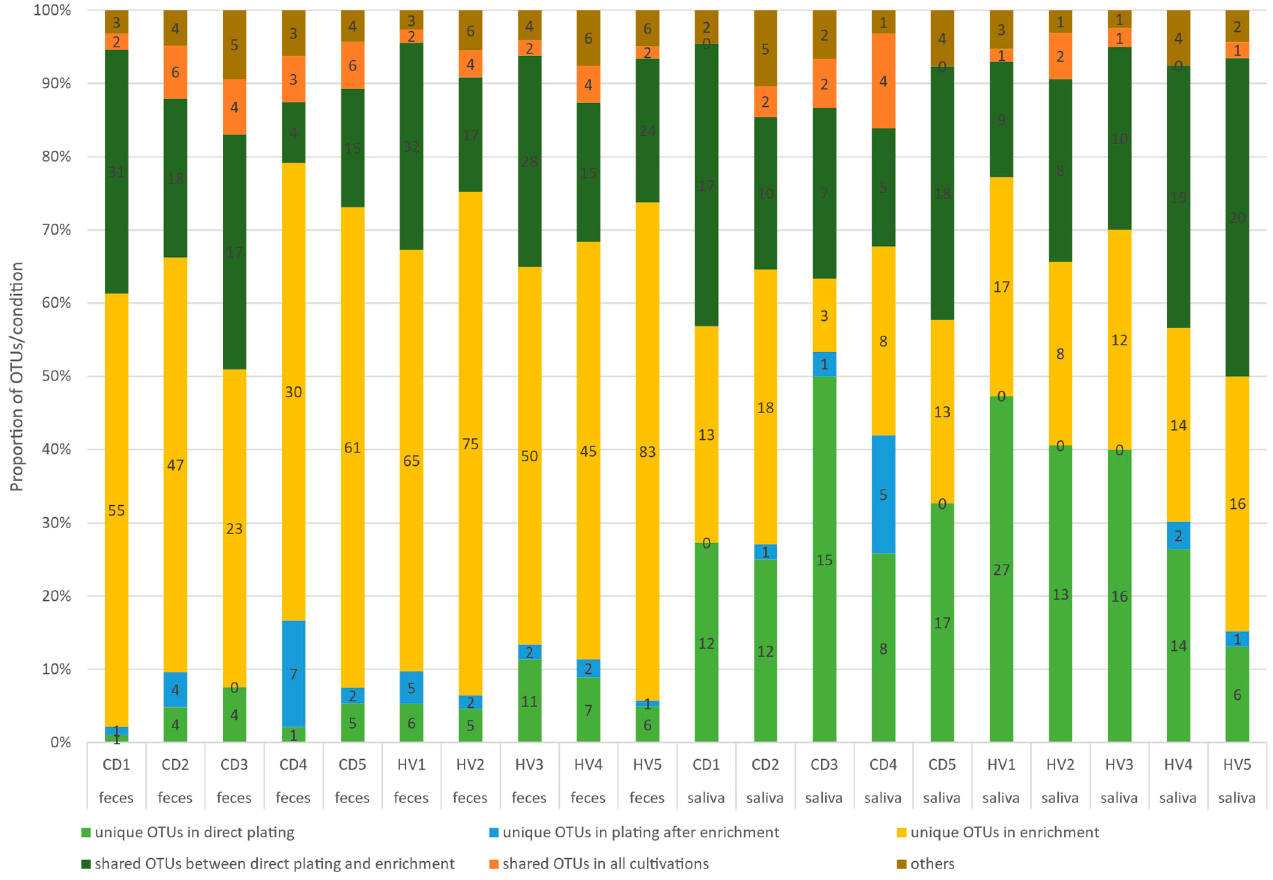
Figure 1. OTUs detected from different cultivation protocols. The term ‘others’ includes OTUs shared between direct plating or plating after enrichment and from enrichment and plating after enrichment. CD: celiac disease patient; HV: healthy volunteer.